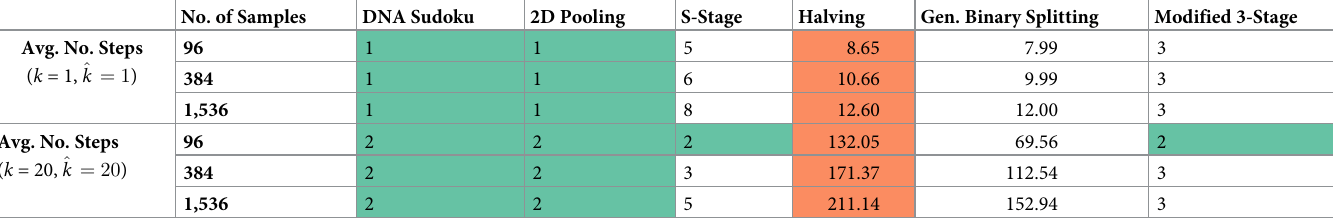
Table 3. Average number of steps for each of the pooling methods for sample sizes N = 96, 384, and 1,536, when k = 1 and k = 20. No. of Samples DNA Sudoku 2D Pooling S-Stage Halving Gen. Binary Splitting Modified